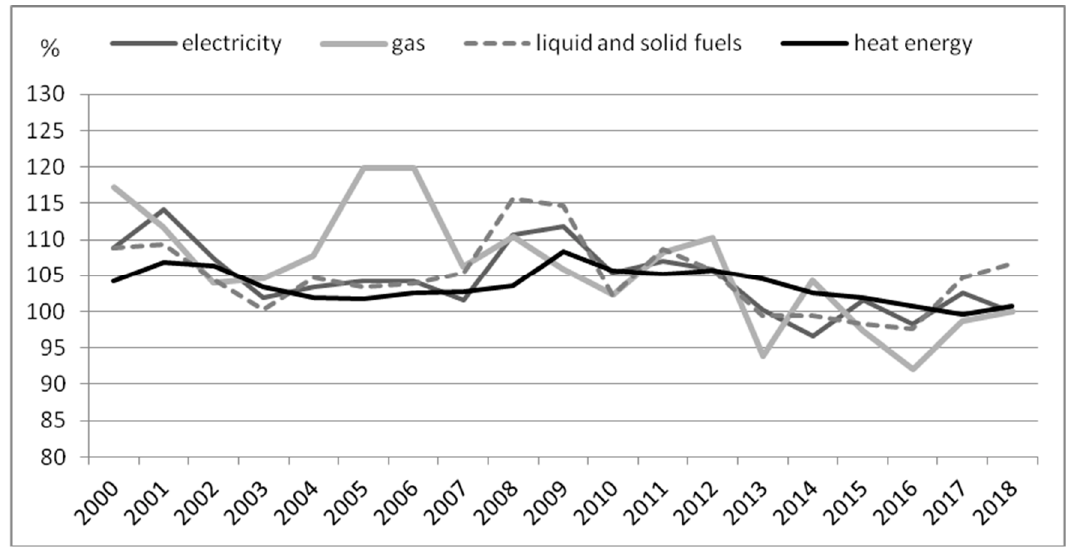
Figure 2. Changes in prices of energy carriers for households in 2000–2018. Source: own study and calculations based on Central Statistical Office (CSO) data.